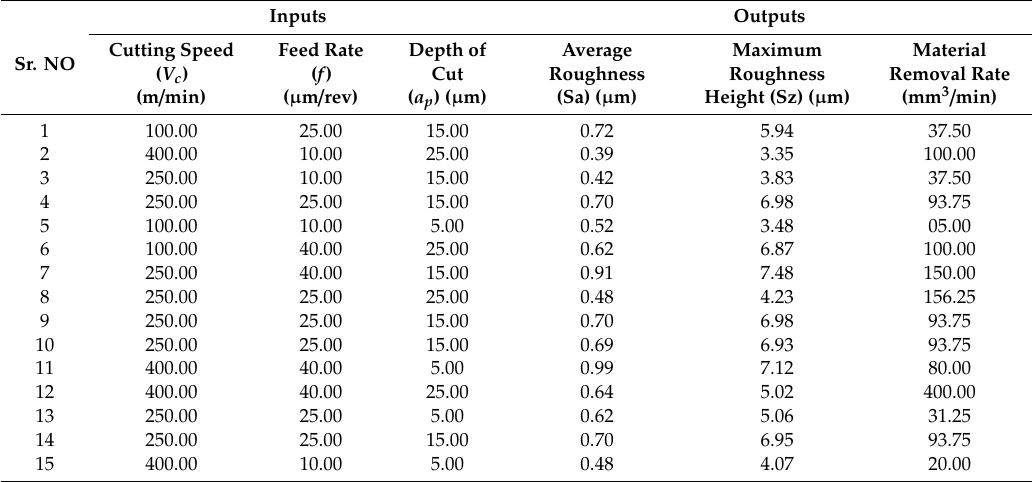
Table 4. Experimental results on Sa, Sz and material removal rate (MRR) for di ff erent cutting